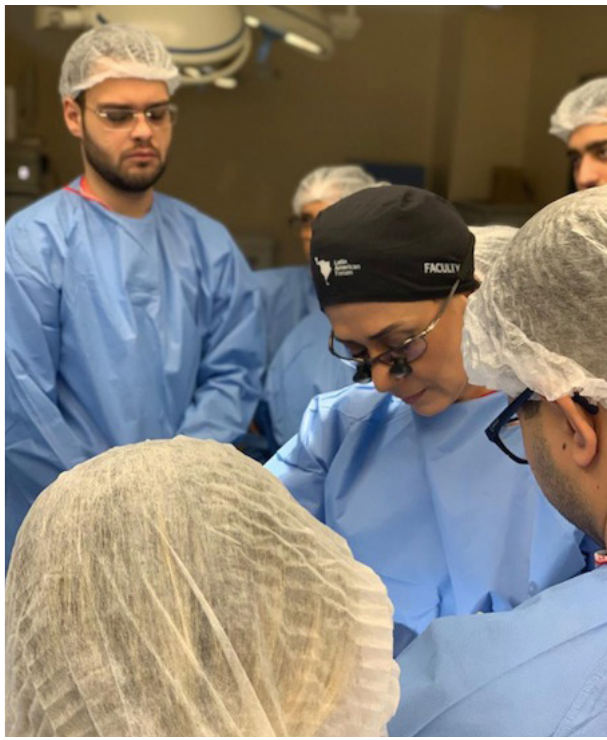
Fig. 3 - Dr. Magaly Arrais, MD, PhD, in the experimental center teaching surgical techniques to both residents and medical students. Image courtesy from the